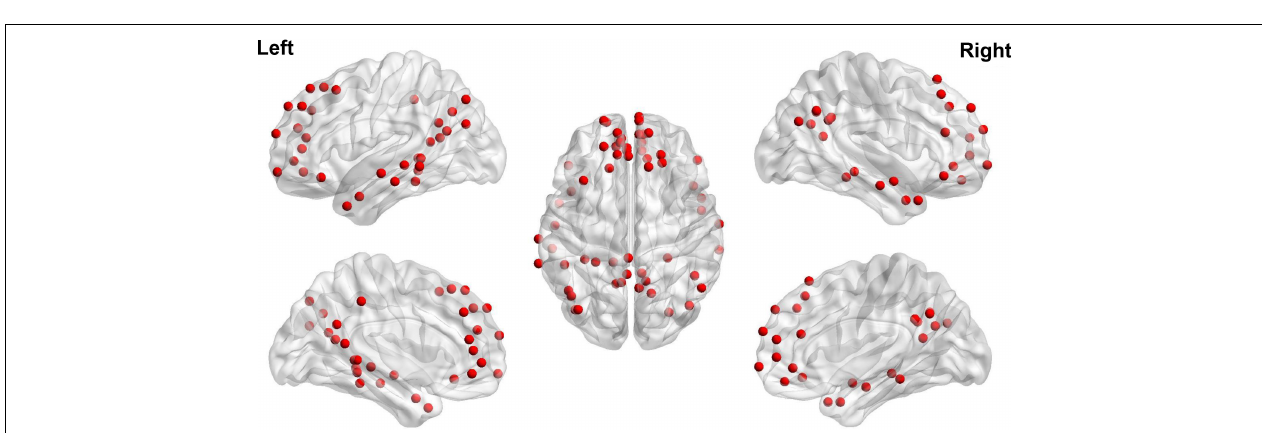
FIGURE 1 | A summary of how to calculate static FC strength and dFC variability (refer to section “Functional Connectivity Strength and Dynamic Functional Connectivity Variability Within Default-Mode Network” for details).